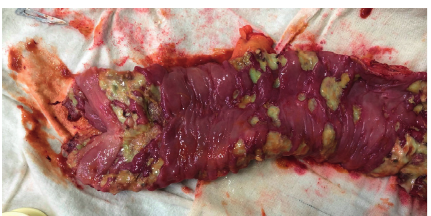
Figure 4: Opened up descending colon showing multiple areas of sloughed off mucosa with necrosis and perforation.